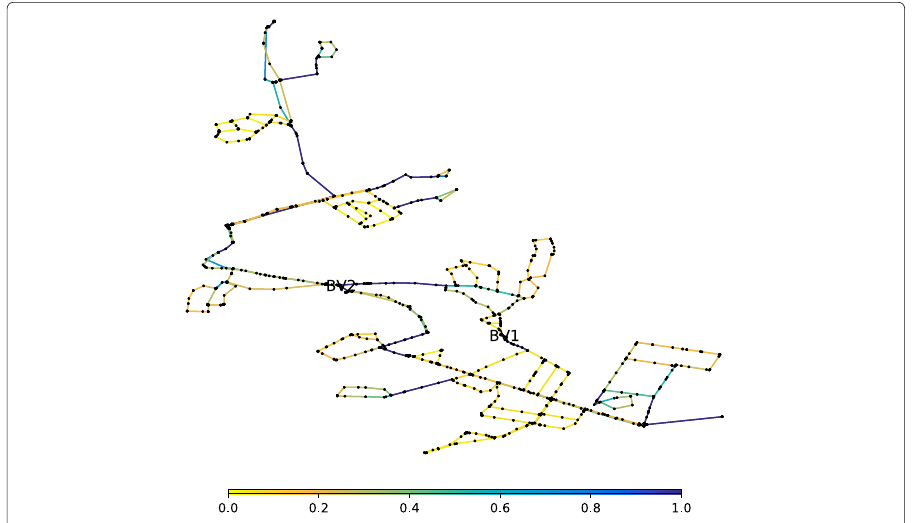
associated with a WFEBC value of 1. The reserve capacity of a link represents the maxi- mum fraction of total nominal demand the network can supply if the link has failed. In the case of BWFL, reserve capacity values extend from 0 (i.e. one or more nodes cannot be supplied following the failure of the link) for bridges to approximately 1.36 (i.e. all nodes can be supplied at least 136% of their nominal capacity at all times) for the least criti- cal links. The results of the graph theoretic WFEBC analysis and hydraulic model based CLA of BWFL links are represented in Figs. 8 and 9: the less critical the link, the closer its colour is to yellow on the selected colour scale; more critical links are represented in dark blue. We observe that: